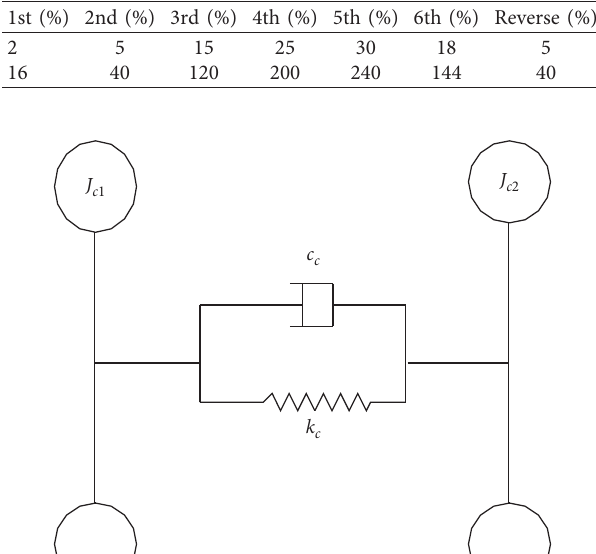
Transmission ratio Table 2: The working life of each gear.